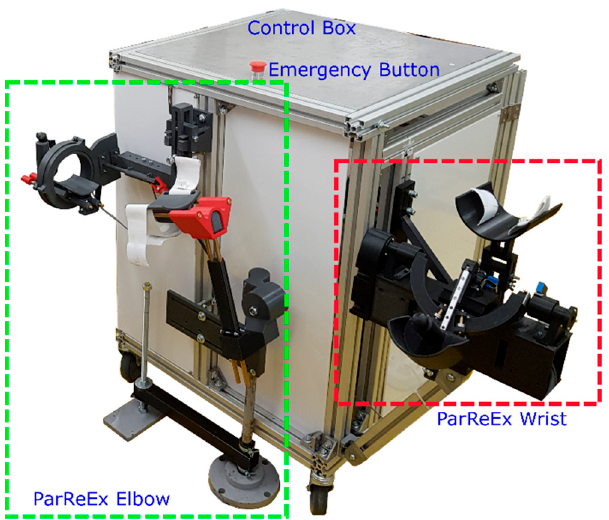
Figure 8. The experimental model of ParReEx robotic system.